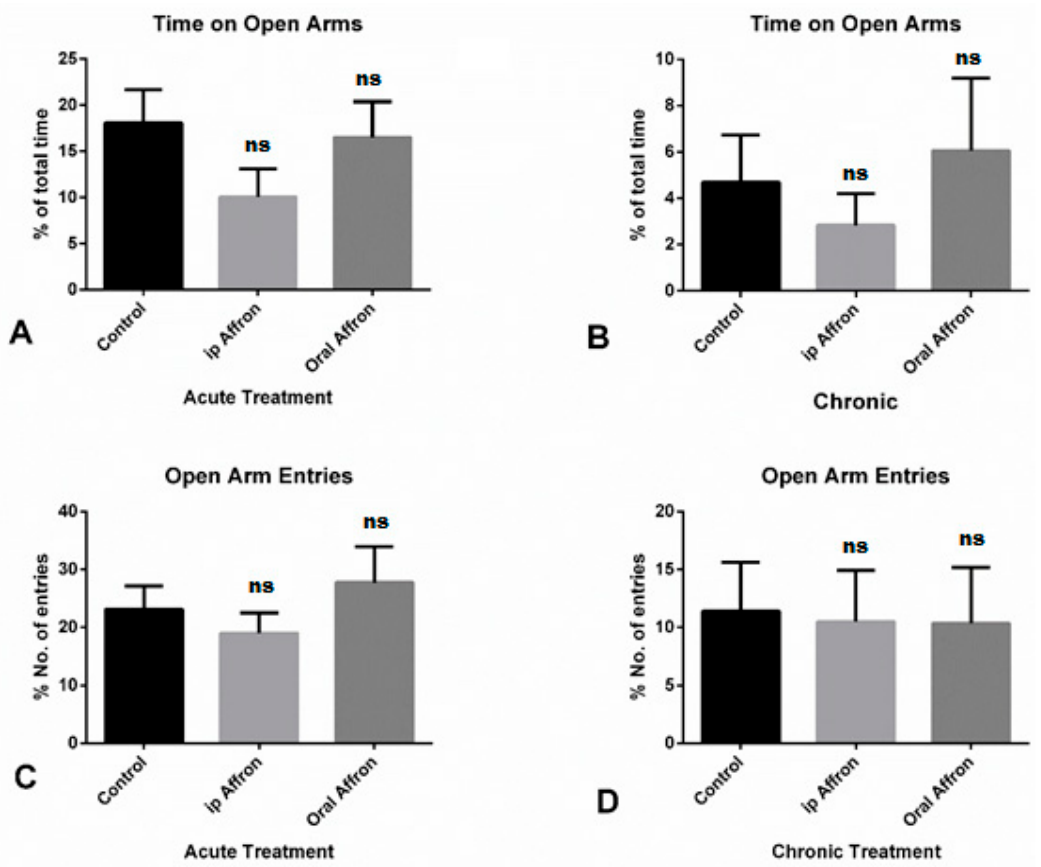
Figure 1. E ff ects of a ff ron in the Elevated Plus Maze. ( A , B ): Percentage of time spent in open arms over the total in the acute and chronic treatment groups, respectively. ( C , D ): Percentage of entries in the open arms in the acute and chronic treatment, respectively. No significant e ff ects were found between any of the groups in any condition (ns). The tests were administered on day one of treatment and on day 21 for the chronic group, 30 min after drug administration.